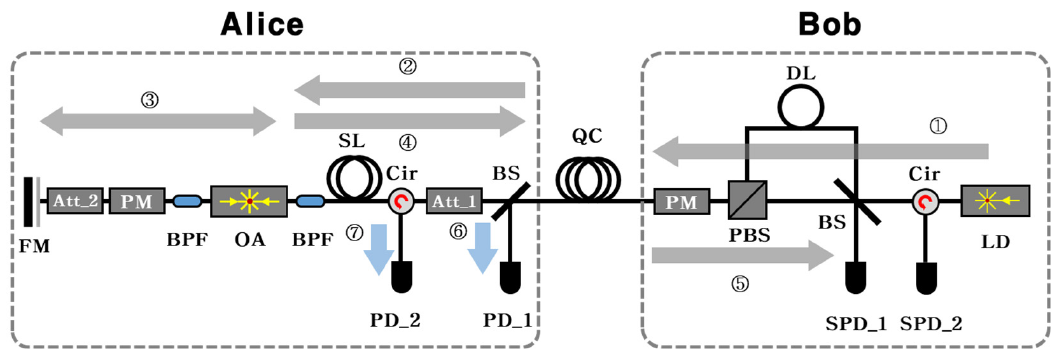
Figure 1. PnP QKD architecture with decoy system. The overall structure is similar to the original PnP QKD, but an optical amplifier (OA), band pass filters (BPFs), a circulator, and an attenuator have been added for generating decoy pulses in Alice. An initial pulse is generated in Bob’s laser diode and then passed through an asymmetric Mach–Zehnder interferometer to generate a time-bin pulse. At this time, to create a similar intensity of pulses of |𝑓⟩ and |𝑠⟩ , the phase modulator in Bob is placed behind the polarization beam splitter. Amplification-based decoy states are generated at OA using double amplification method. The circulator in Alice is used to monitor the output signal, and it plays a role in large attenuation of the pulse passing in the reverse direction of the circulator, as well. After that, the pulse is precisely attenuated to a single-photon level by the attenuator of Att_1 and transmitted to Bob. (FM: Faraday mirror (NFRM-15, General photonics), PM: phase modulator (PM-0S5, Eospace), BPF: Bandpass filter (of003, Fiberpia), OA: optical